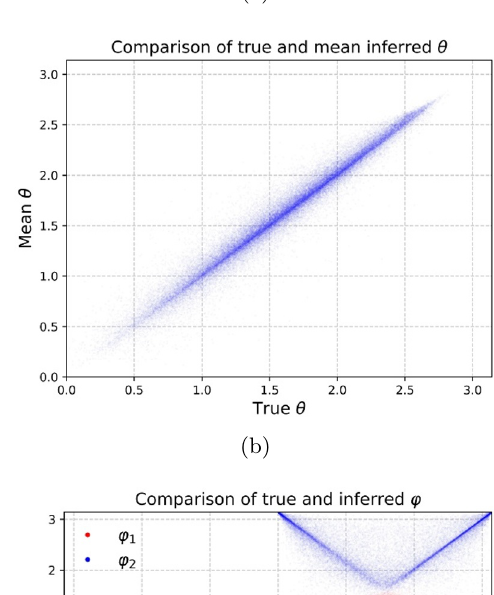
Figure 3 . In the W (cid:6) ( l(cid:23) ) h ( b (cid:22) b ) process, the ambiguity in the z momentum of the neutrino leads to two possible values of each of the three angles. Plots (a) and (b) above show the scatter plot for the mean of the solutions for (cid:2) and (cid:18) vs the true value. Plot (c) includes two solutions for ’ (shown in red and blue) in a scatter plot vs the true value.